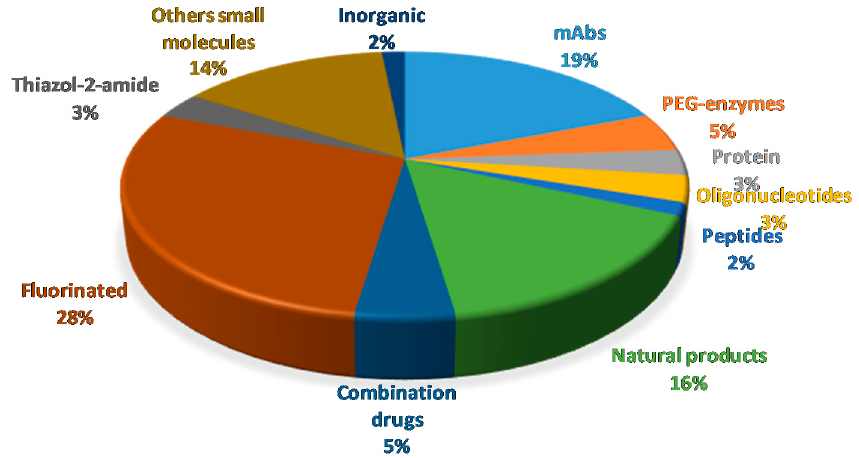
Figure 22. Drugs approved by the FDA in 2018 and classified on the basis of their chemical structure.